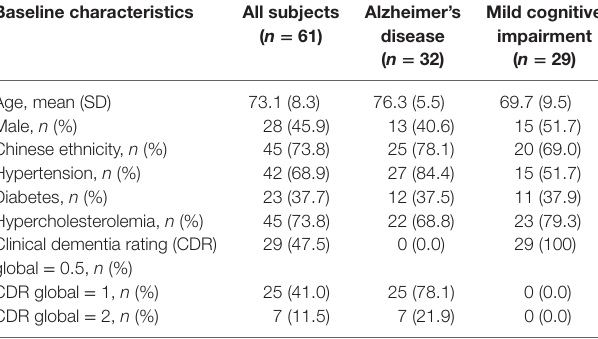
TaBle 1 | Baseline characteristics of study subjects.